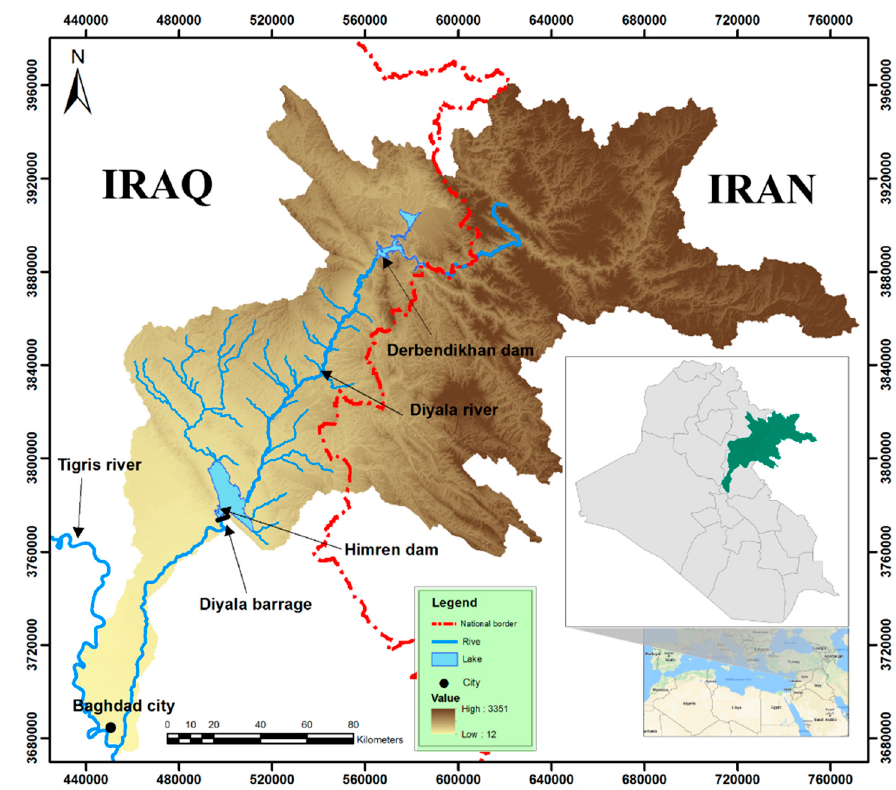
Figure 3. Catchment area of the transboundary Diyala river basin in Iraq.